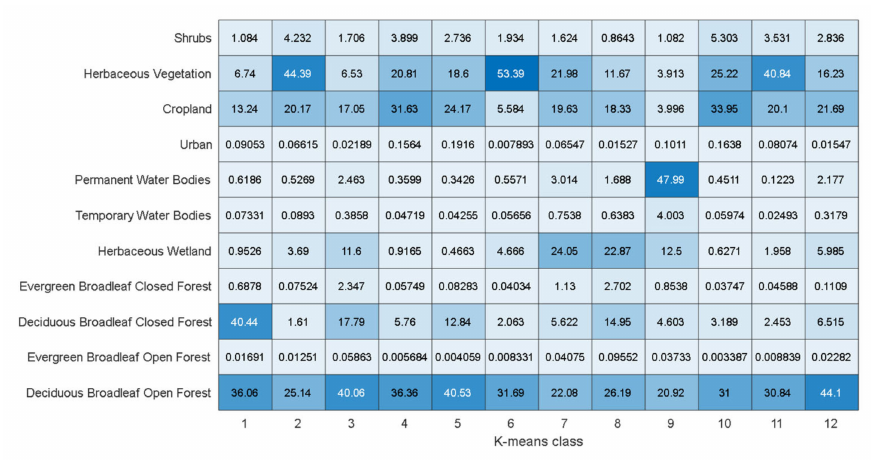
Figure 11. Class pixel relative populations for the multi-temporal K-means classified